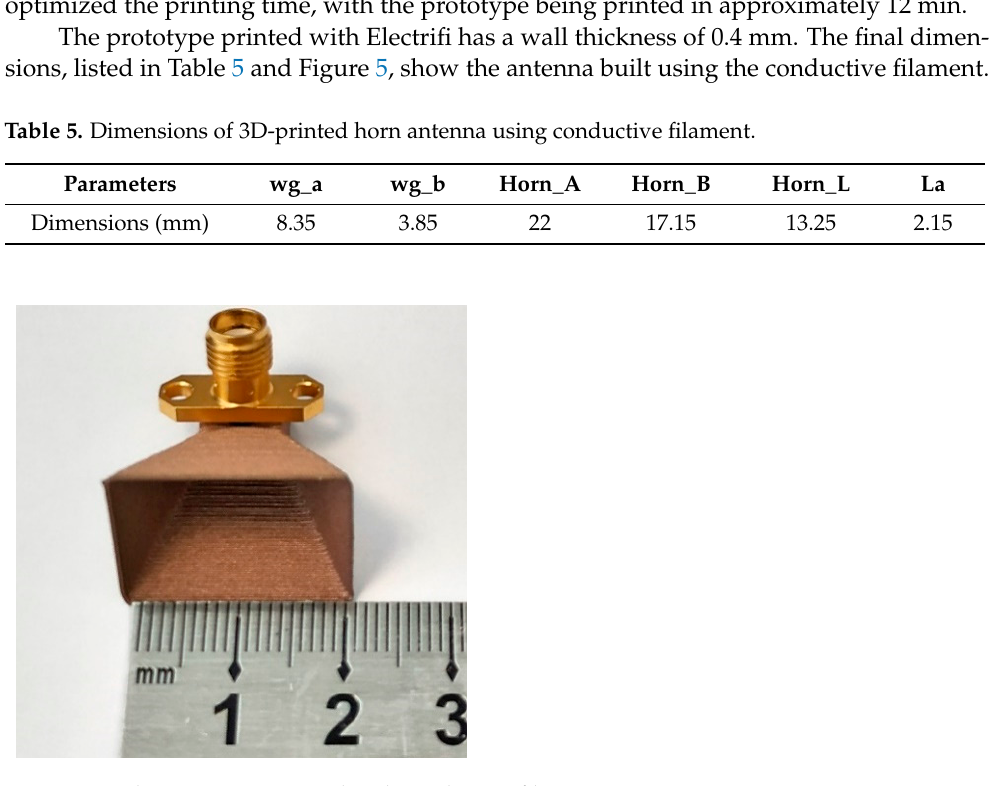
Figure 5. 3D horn antenna printed with conductive filament.